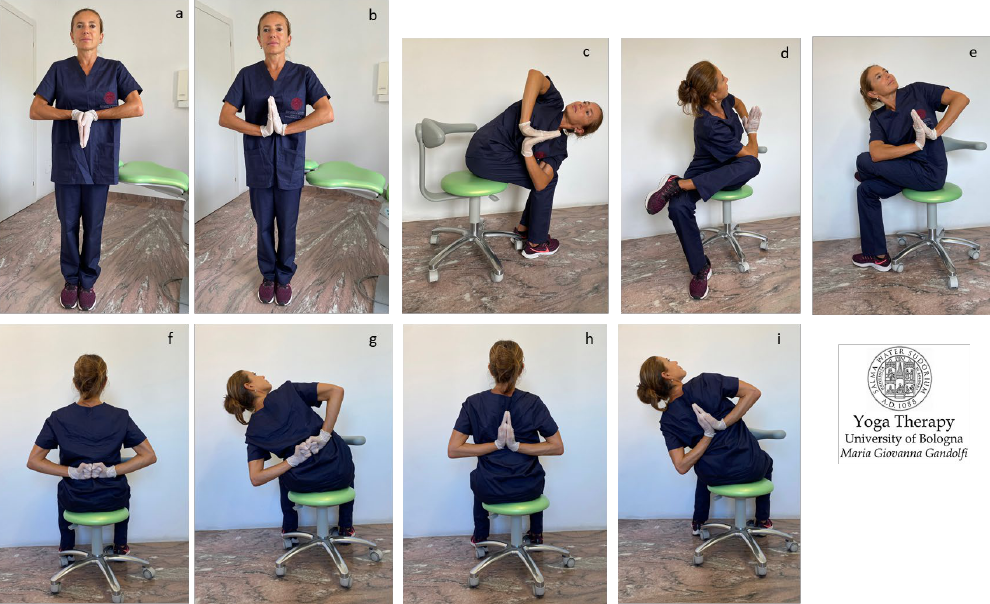
Figure 4. The figure shows the proposed āsana for shoulder mobilization. Purva Viparita Na- maskarāsana ( a ), Purva Namaskarāsana (prayer pose, hands in front side) ( b ), Purva Namaskarāsana Parivrtta Utkatāsana (twisting chair pose with hands in prayer pose in front side) ( c ), Eka Pada Parivrtta Utkatāsana (one-legged revolved chair pose) ( d , e ) , Upavistha Paschima Brahma Mudra ( f,g ), Upavistha Paschima Namaskarāsana ( h ) and Parsva Paschima Namaskarāsana (side bending with hands in prayer pose on back front) ( i ). The stretching and destressing the of infraspinatus and teres ( mainly teres minor) rotator cuff muscles is intense ( f – i ).